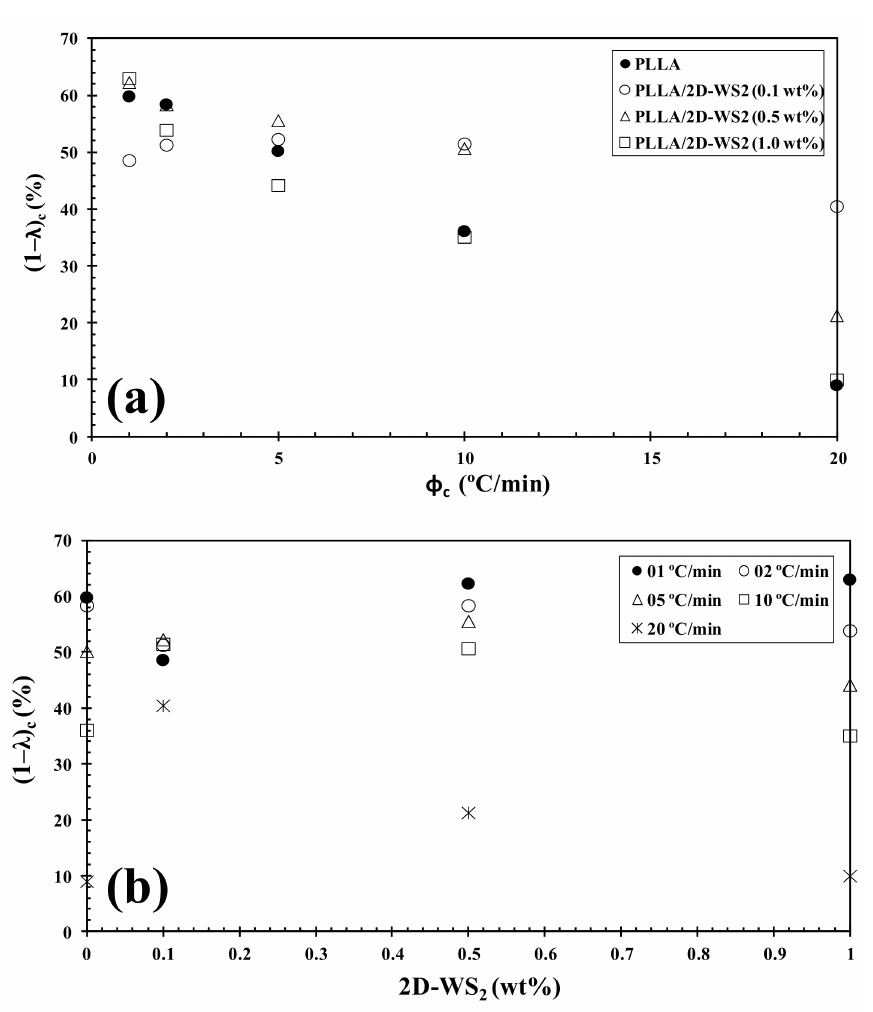
Figure 9. Variation of the crystallinity (1 − λ ) c for PLLA/2D-WS 2 nanocomposites with ( a ) cooling rate and ( b )